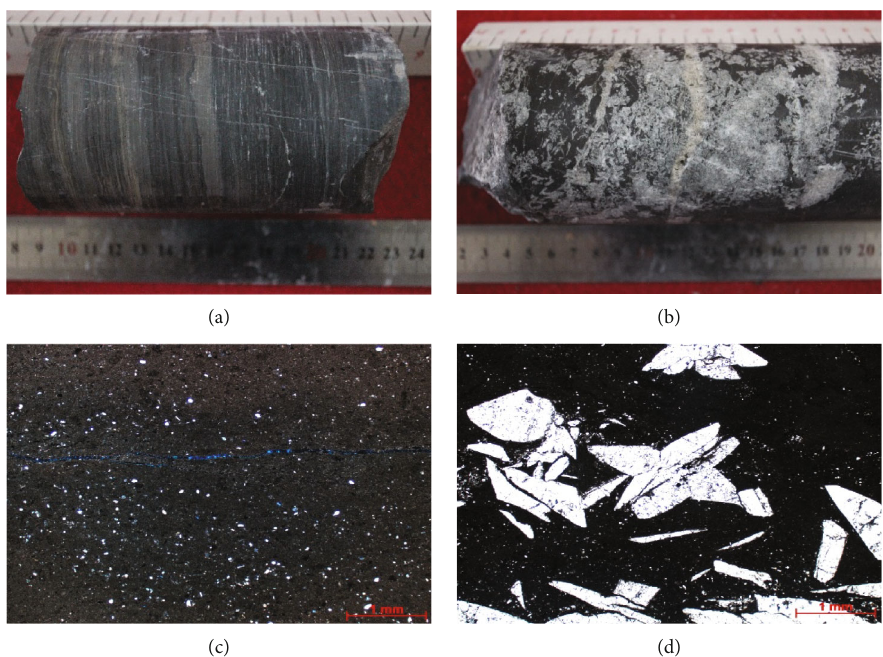
Figure 4: Petrological characteristics of the reservoir rocks. (a) Dolomitic mudstone, sampling depth of 4138 m, (b) calcite dolomites with gypsum, sampling depth of 3731m, (c) silty mudstone with dolomite, and (d) dolomicrite with